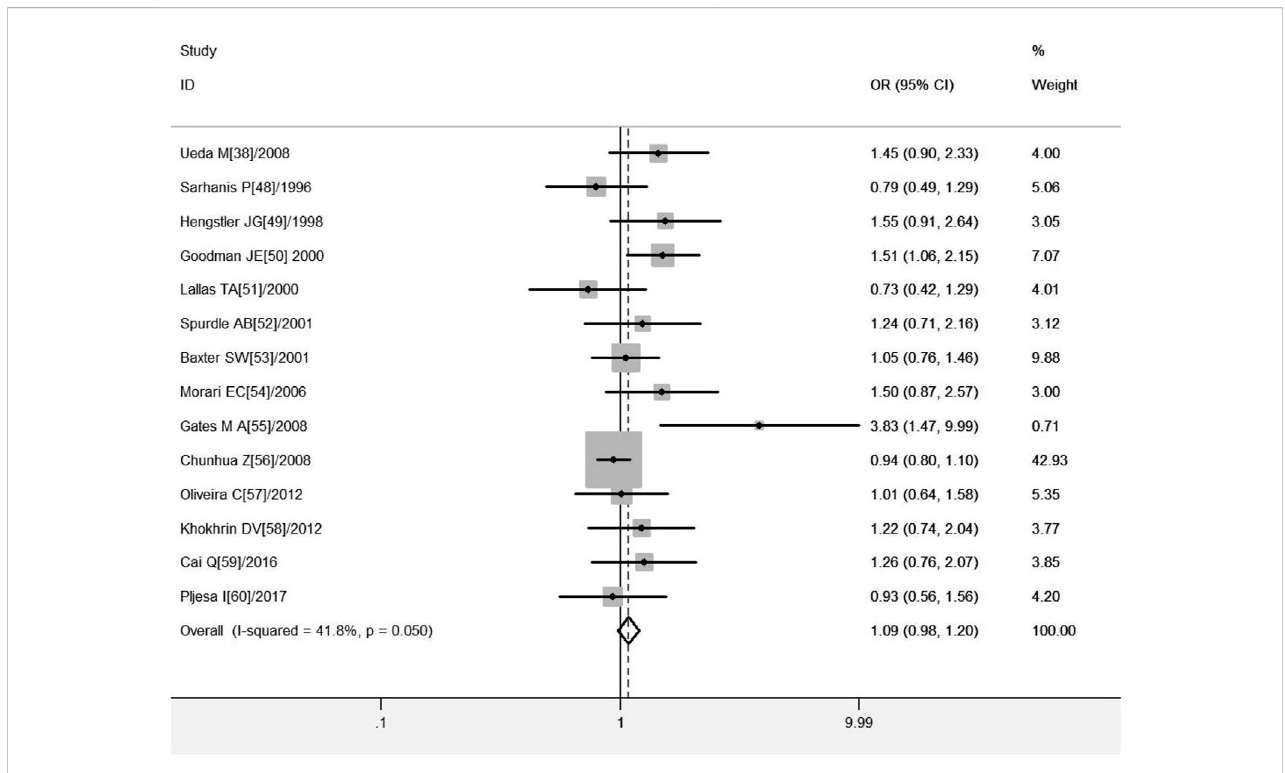
FIGURE 4 Forest plot of meta-analysis of the relationship between GSTM1 gene polymorphisms and ovarian cancer